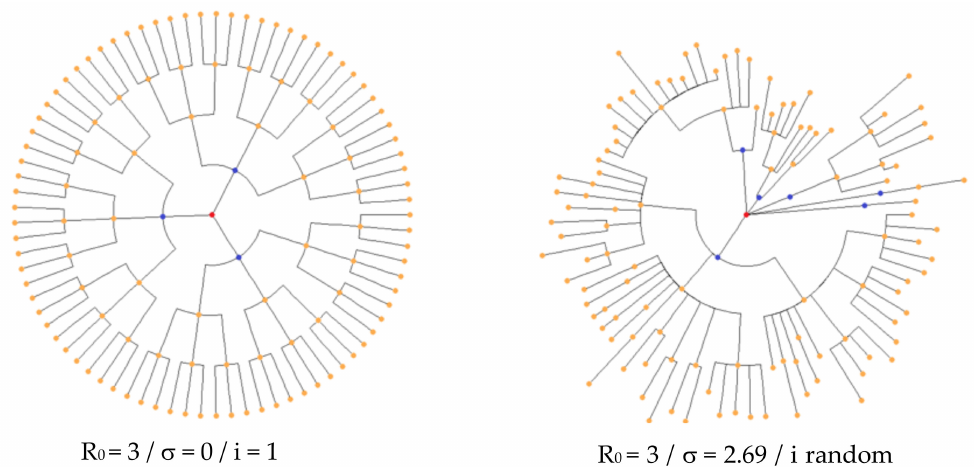
Figure 1. Spread of an epidemic disease from the first infectious “patient zero” (in red), located at the center of its influence sphere comprising the successive generations of infected individuals, for the same value of the reproduction number R 0 = 3, with a deterministic dynamic ( left ) and a stochastic one ( right ), with standard deviation σ of the uniform distribution on an interval centered on R 0 and with a random variable time interval i between infectious generations (after